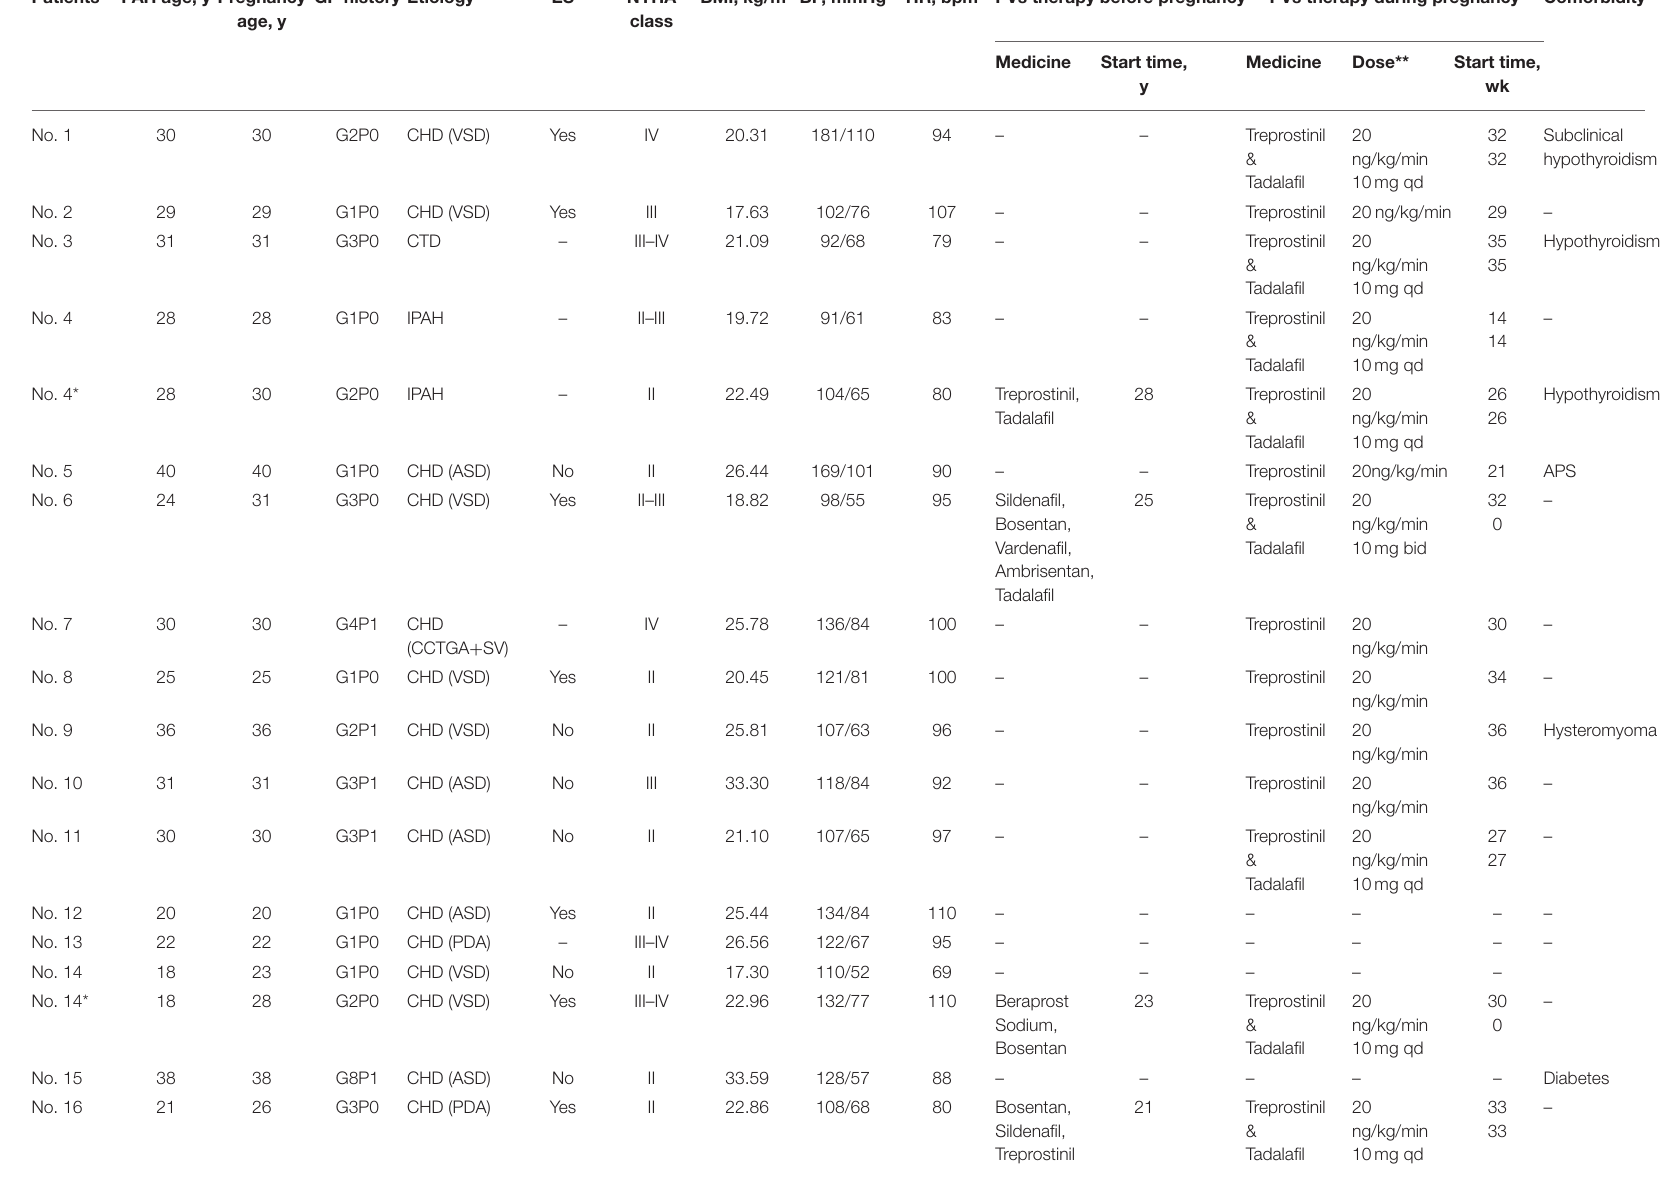
TABLE 1 | Baseline characteristics and management of PAH patients with pregnancy. Patients PAH age, y Pregnancy age,